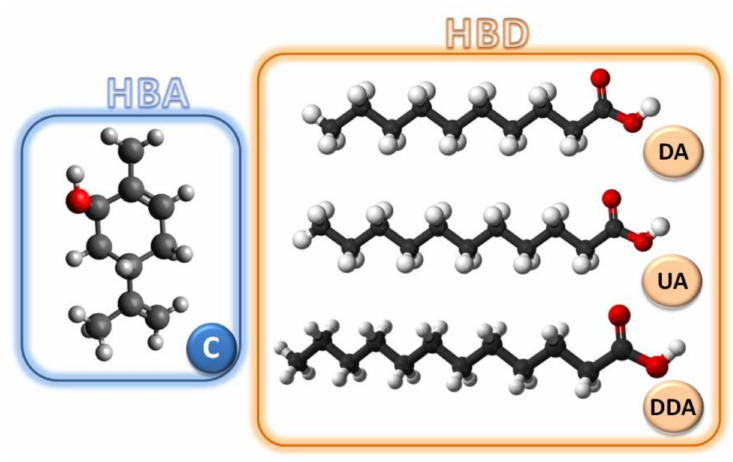
Figure 18. Structures of HBA and HBD used for DES